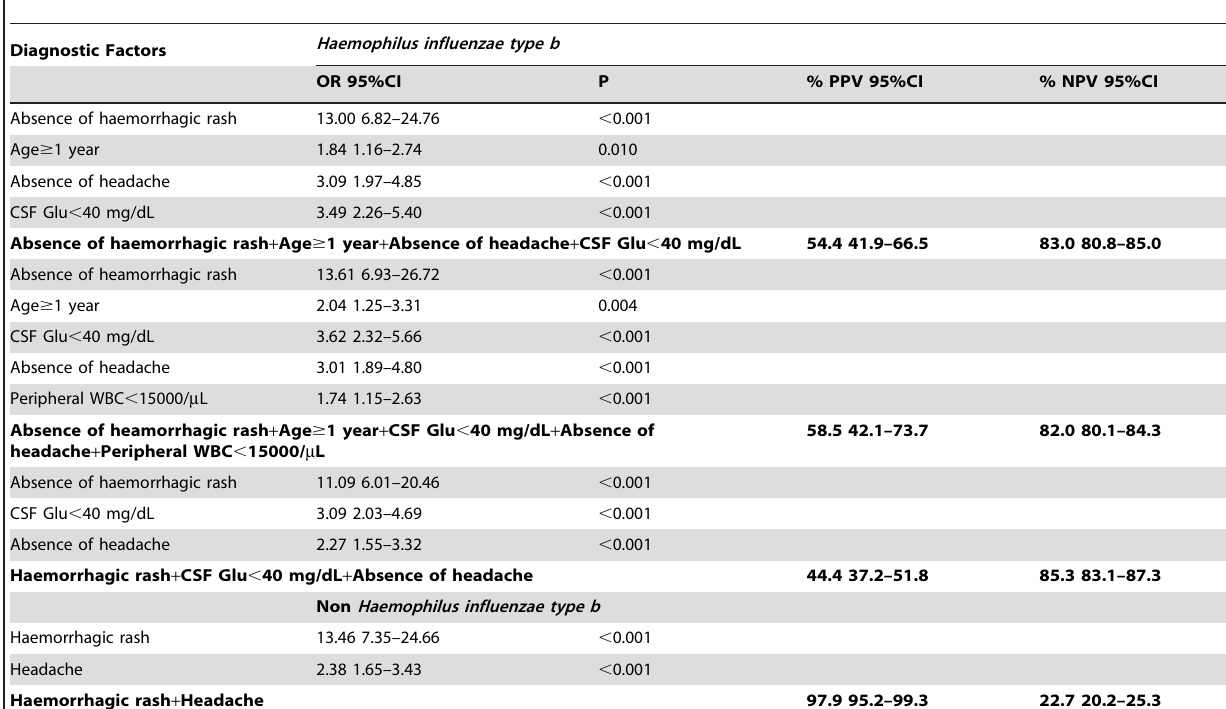
Table 7. Multivariate analysis of groups of diagnostic factors for the diagnosis of Haemophilus influenzae type b.